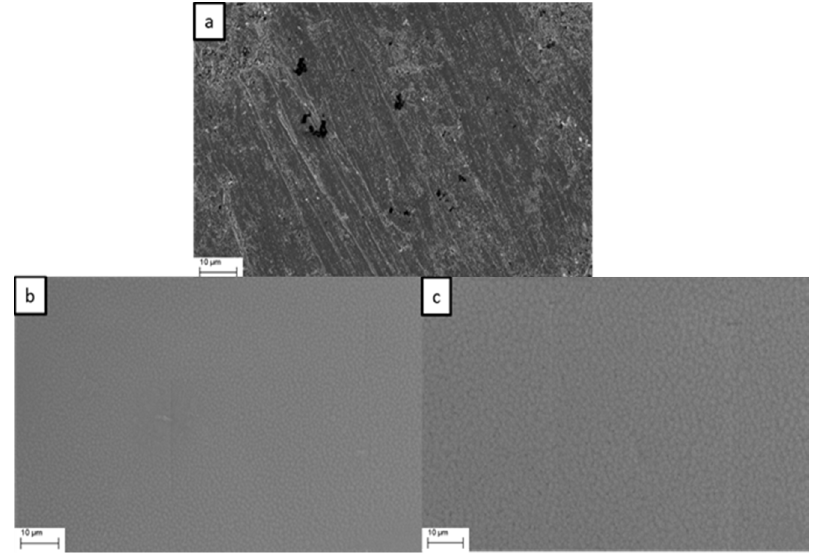
Figure 3. SEM image of ( a ) polished metal; ( b ) SNAP coated metal; and ( c ) SNAP/PIL hybrid film coated metal.